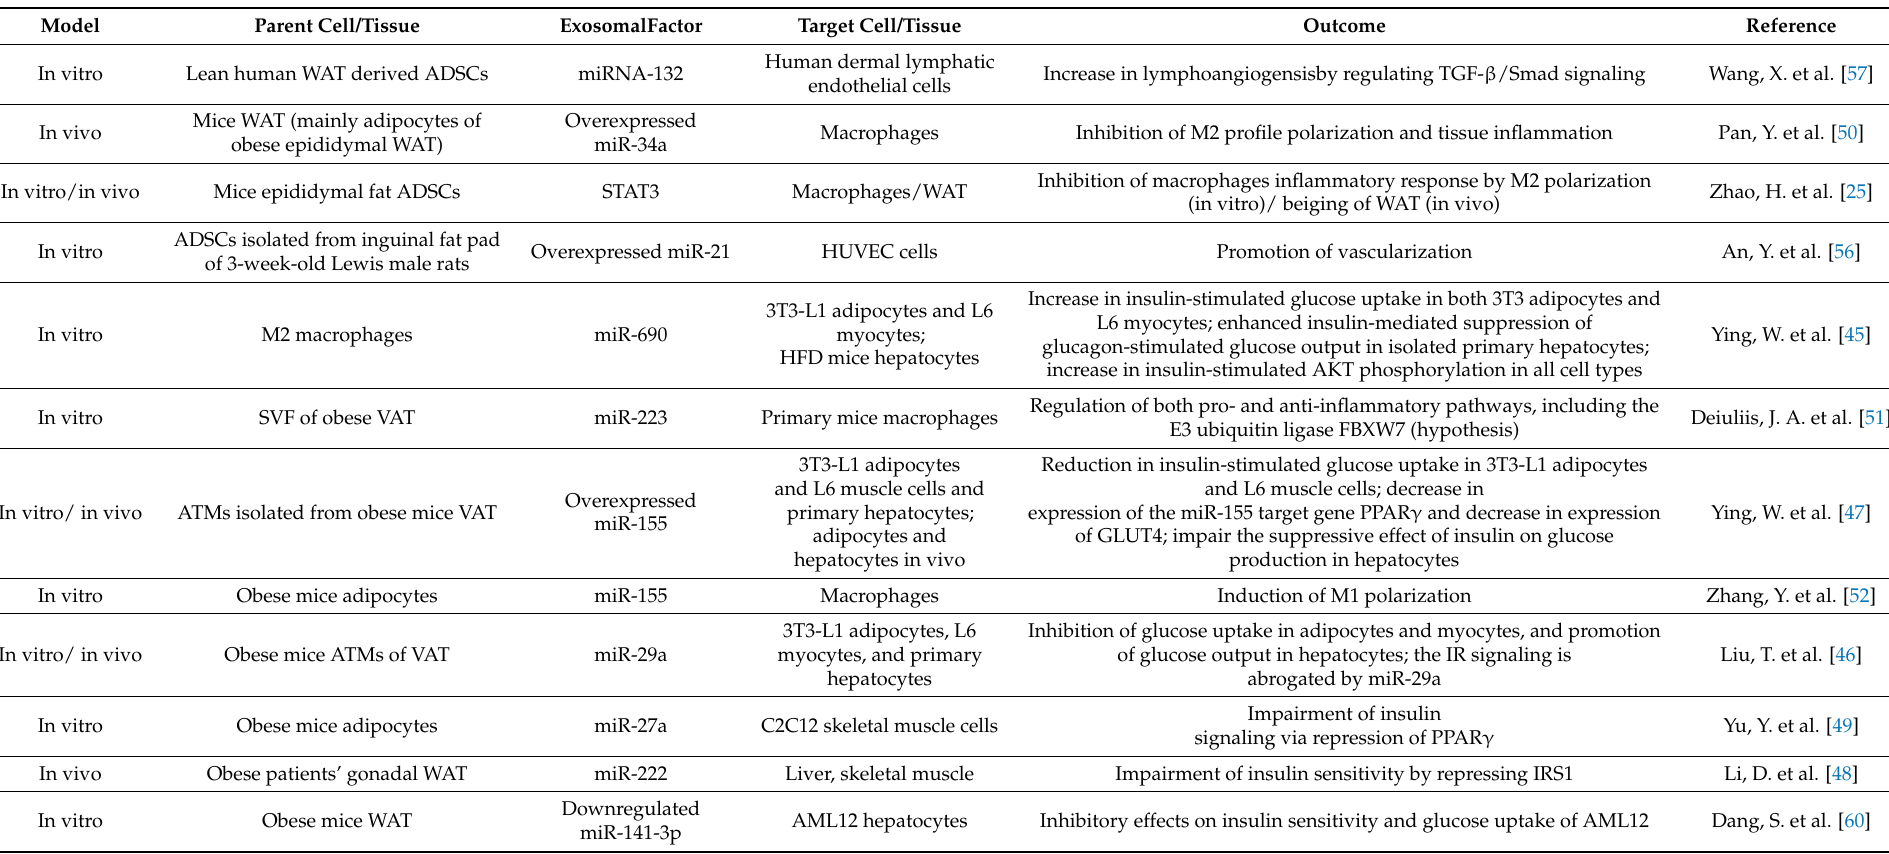
Table 1. Crosstalk between adipose-derived exosomes and target cells. The table describes exosome experimental models, emphasizing possible factors and their biological effects on the target